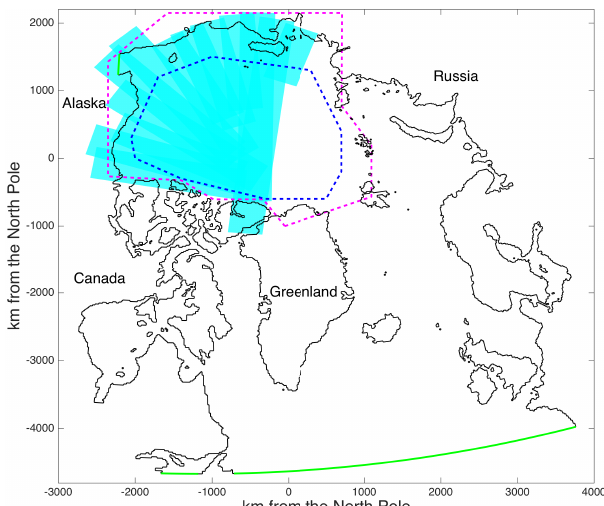
Figure 1. Model domain projected on a polar stereographic plane, with open boundaries in green. The region delimited by the dashed blue line and the cyan area is used to compute the drift and deforma- tion statistics. The dashed line in magenta shows the area for which the mean ice thickness and ice volume time series are